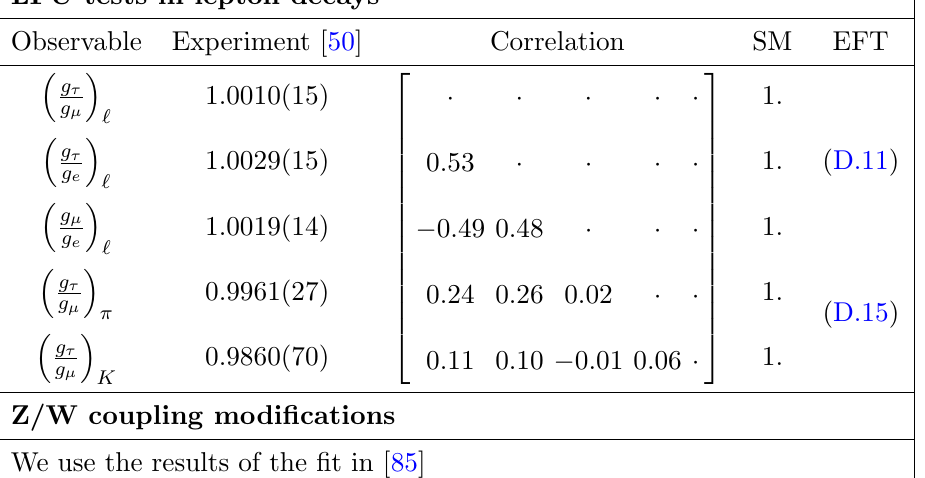
Table 9 . List of observables involving LFV transitions and LFU